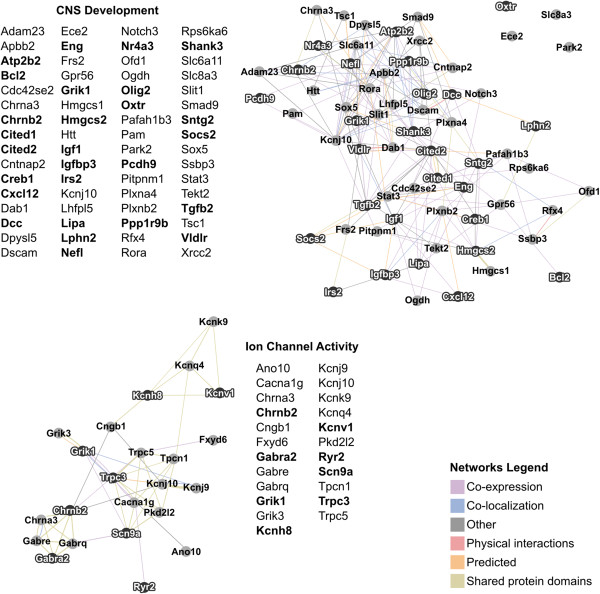
Networks of genes related to CNS development and ion channel activity in significant MPOA results. CNS development and ion channel activity related genes identified by ToppCluster and NIH DAVID were exported into GeneMania for visualization. A list of genes found within each individual network are found to the side of the cluster. Bolded terms in the list represent genes that are up-regulated in postpartum compared to virgin females, and non-bolded terms correspond to genes down-regulated in postpartum versus virgin females. Within the cluster itself, up-regulated genes have white text with black nodes, and down-regulated genes have black text with gray nodes. The distance between two nodes corresponds with the strength of their interactions, with the type of interaction denoted by the color found in the network legend at the bottom right of the figure.